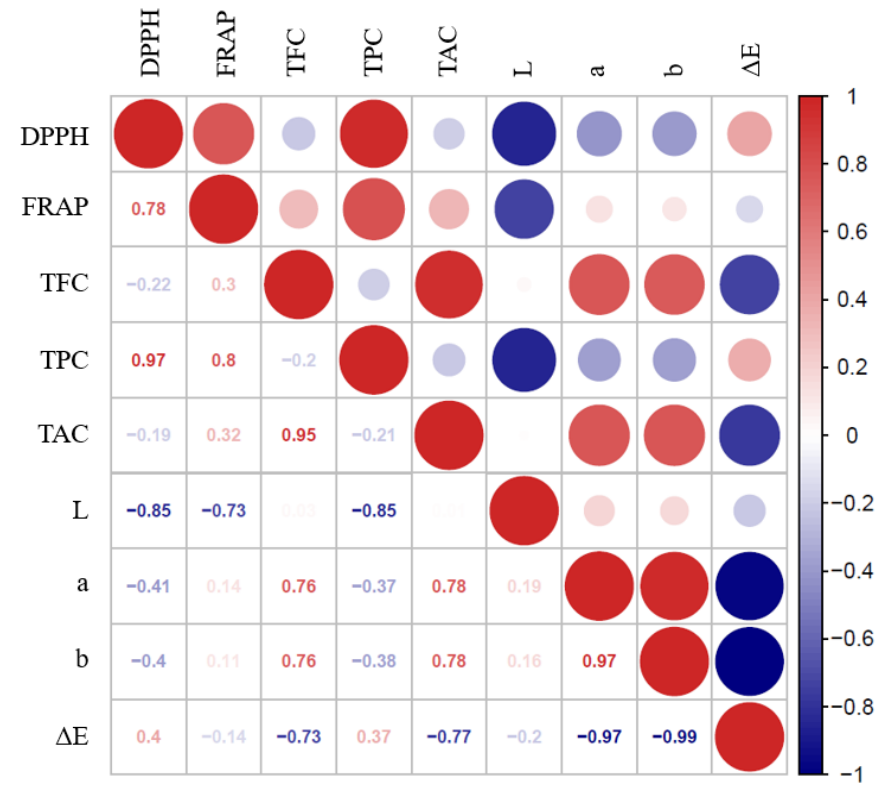
Figure 6. Correlation between the color attributes, antioxidants, and antioxidant capacity of grape juice.